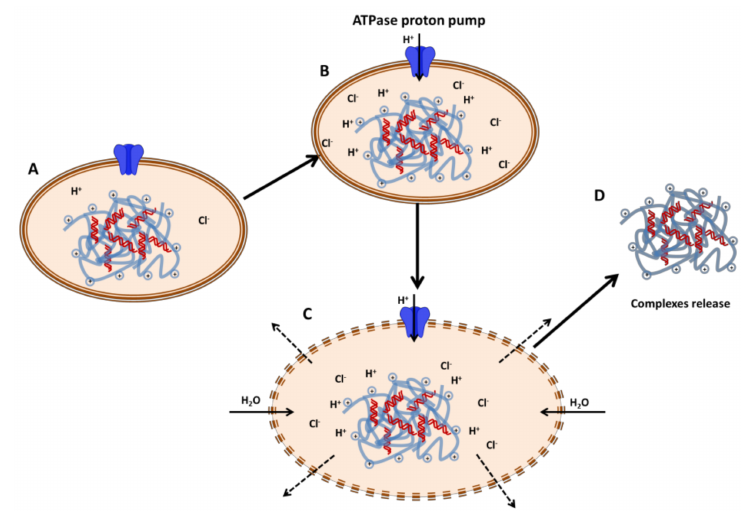
Figure 2. Schematic representation of the “proton sponge” hypothesis in which the endosomes containing the complexes with protonable polymers ( A ) evolve to late endosomes where protons are introduced by ATPase proton pumps, producing protonation of the polymer and a reduction in the pH ( B ); subsequently, chloride ions will be introduced in a non-active way causing a water inflow due to the osmotic pressure ( C ). Swelling of the endosomes leads to their rupture and finally release of their content into the cytoplasm ( D